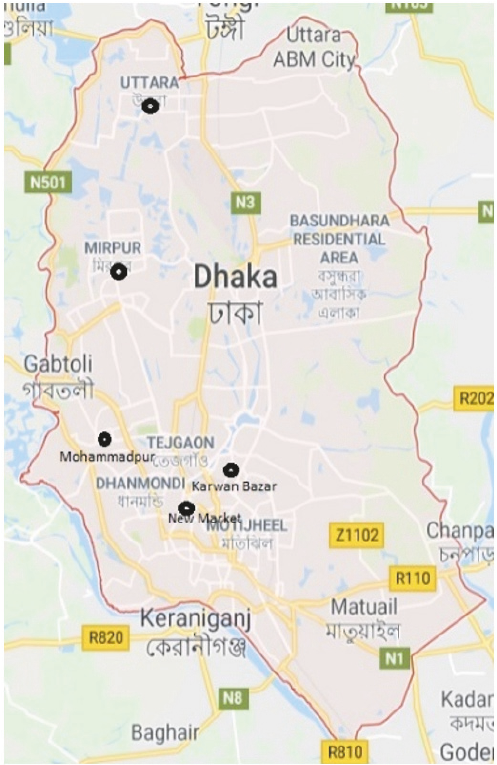
Figure 1: Sampling location of the study area in Dhaka